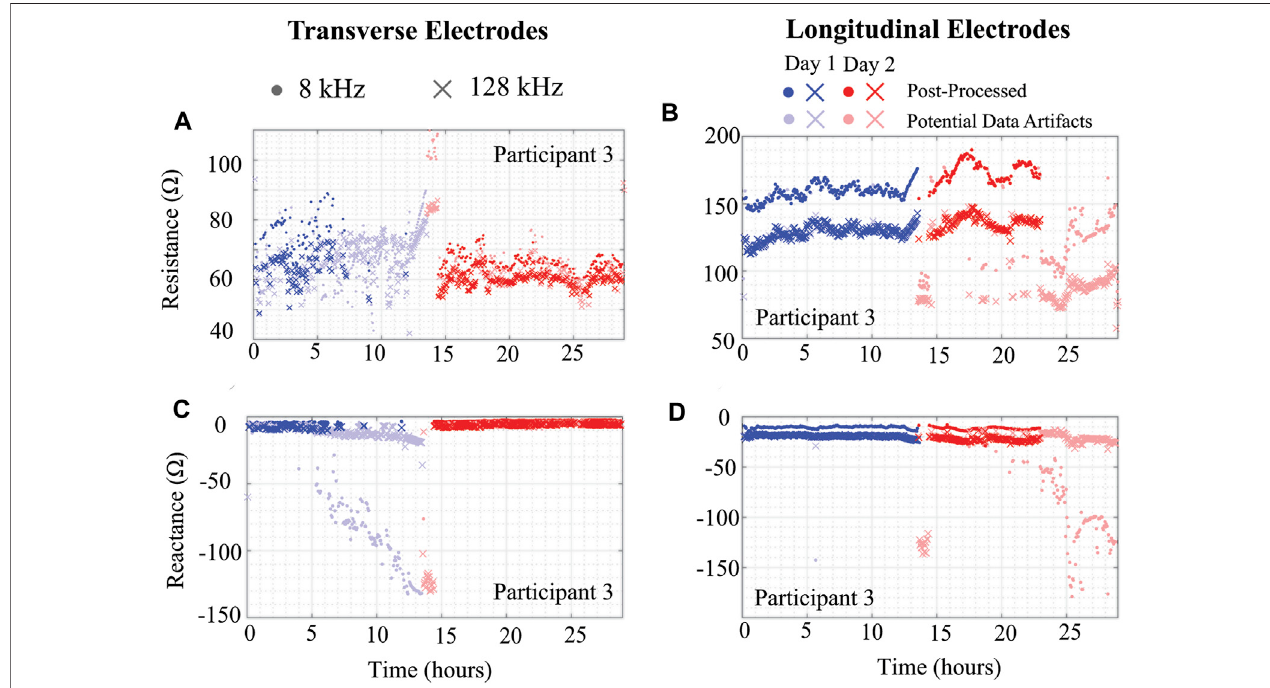
FIGURE 6 | (A,C) Transverse and (B,D) longitudinal knee tissue resistance and reactance (8 kHz, 128 kHz) of Participant 3 using wearable sensing system over 2 days.